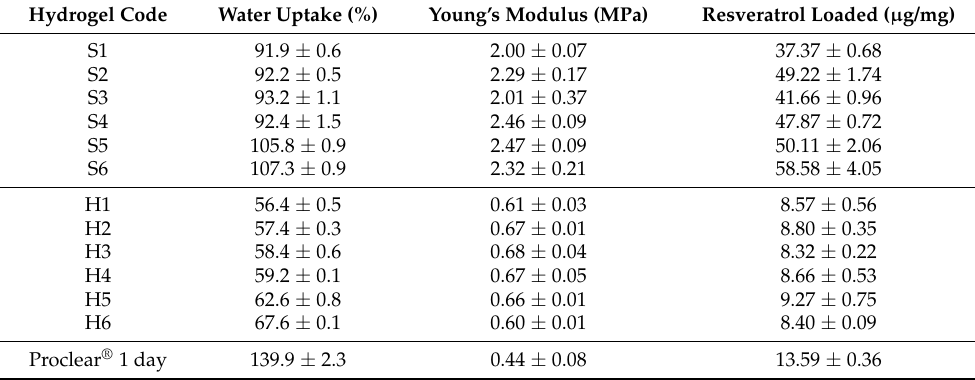
Table 2. Water uptake at equilibrium and Young’s modulus (mean values ± S.D.) for all non-loaded silicone hydrogels (S1–S6) and HEMA hydrogels (H1-H6) immersed in water at room tempera- ture and amounts of resveratrol loaded when the hydrogels were soaked in a resveratrol solution (100 µ g/mL) in ethanol:water 10:90 v / v medium at 36 ◦ C and 180 rpm for 72 h without intermedi- ate